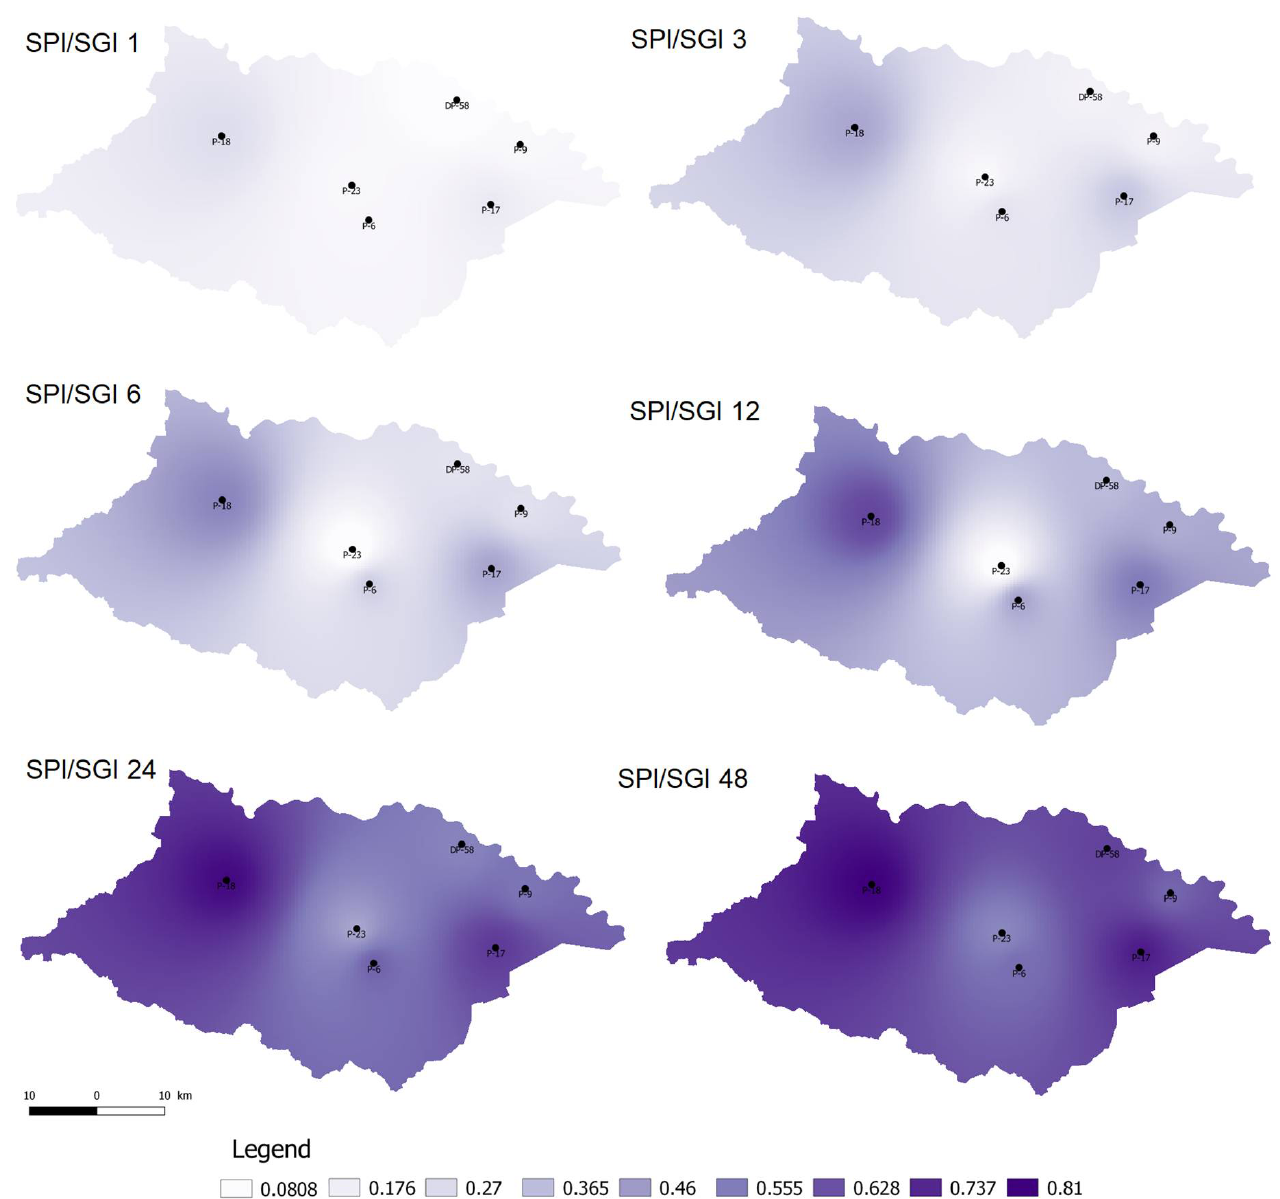
Figure 7. Spatial distribution of SPI/SGI correlation over different time scales.